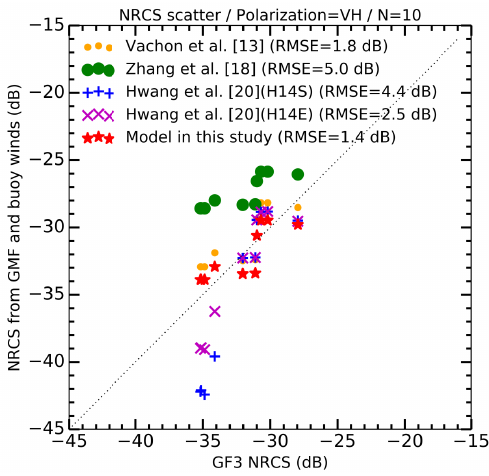
Figure 13. Same as Figure 7, but for VH polarization. The GMFs used include four previous models and one model developed using GF-3